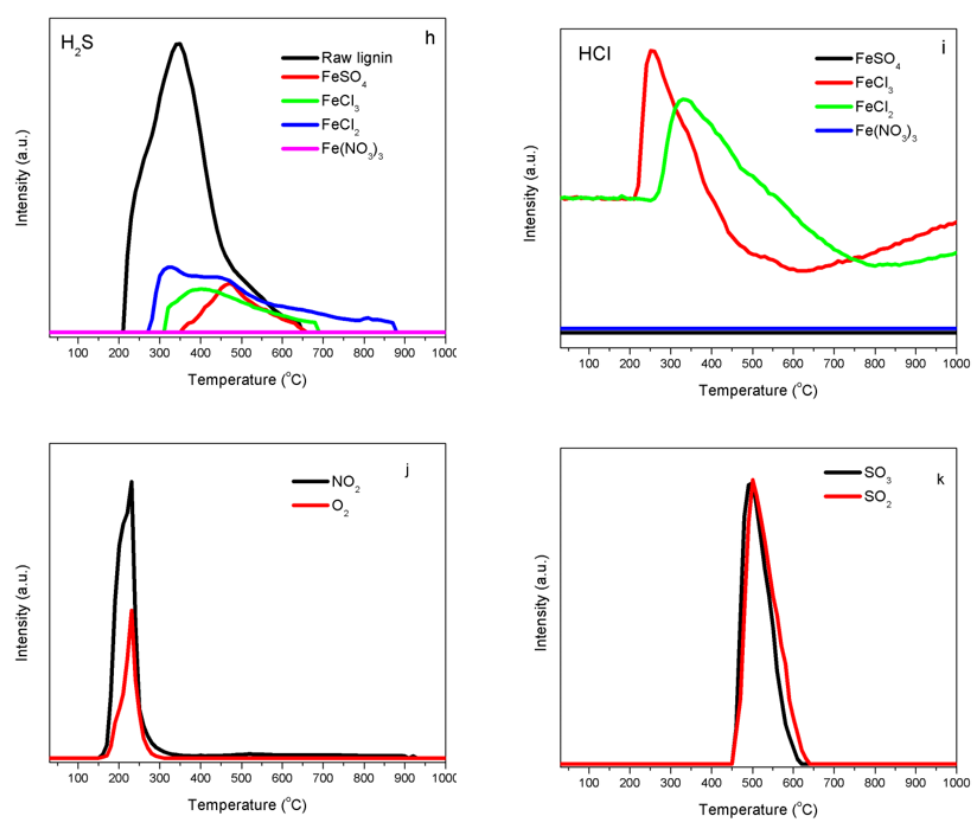
Figure 2. Evolution of gases and volatiles from thermally treated kraft lignin samples promoted with different iron compounds (FeCl 2 , FeCl 3 , FeSO 4 and Fe (NO 3 ) 3 ): ( a ) H 2 , ( b ) CH 4 , ( c ) CO, ( d ) CO 2 , ( e ) phenol, ( f ) benzene, ( g ) CH 3 OH, ( h ) H 2 S, ( i ) HCl (from FeCl 2 , FeCl 3 ), ( j ) NO 2 and O 2 (from Fe (NO 3 ) 3 ), ( k ) SO 2 and SO 3 (from FeSO 4 ).